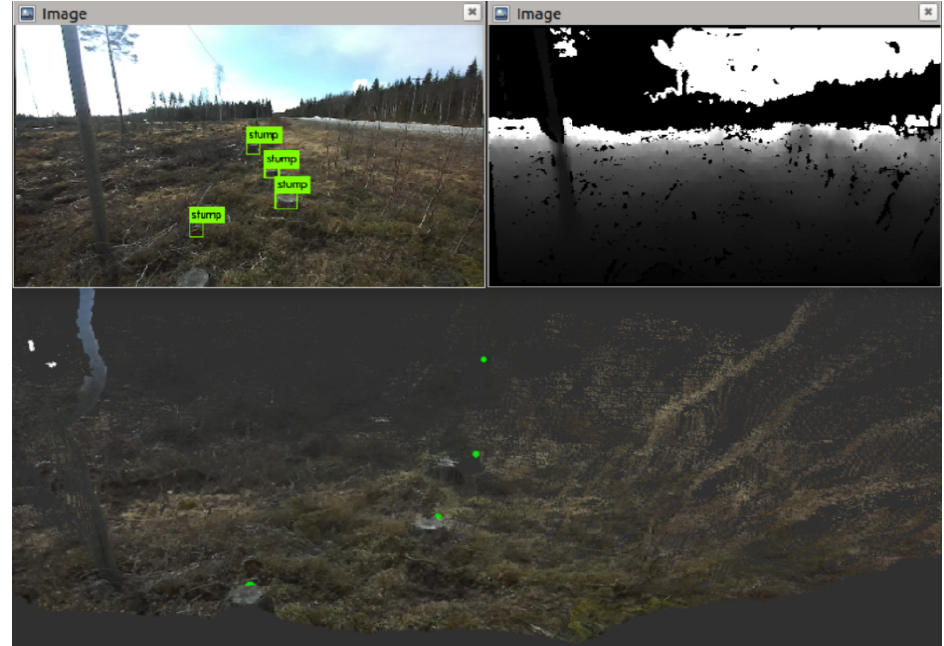
Figure 8. Visualization of results in the RVIZ window. Top left: RGB image with identified objects in green boxes; Top right: Greyscale depth image; Bottom: isometric view of colorized 3D point-cloud data and overlaid red spheres depicting object positions.